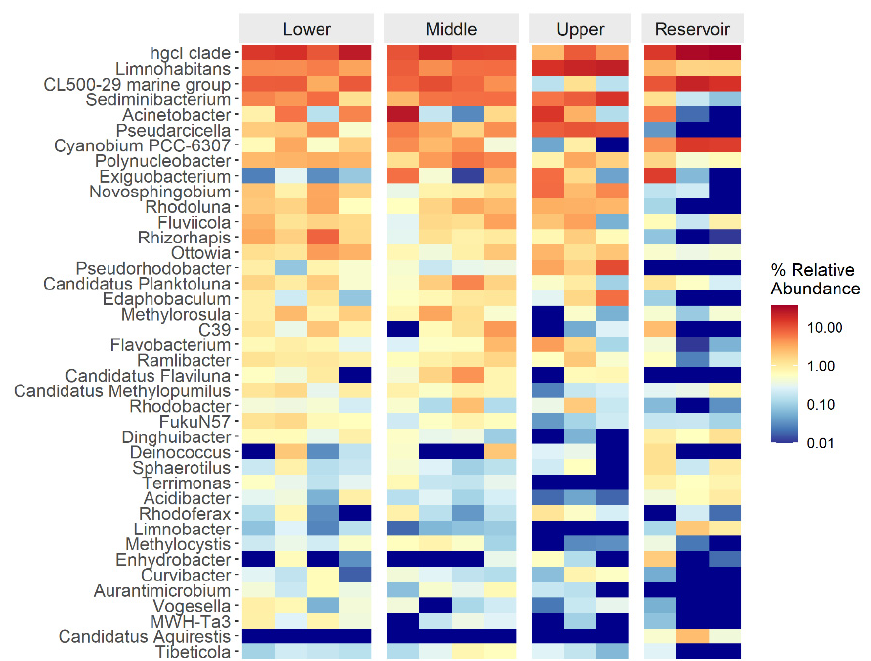
Figure 5. Top 40 taxa at genus level of the 14 water samples. The PCoA plot and PerMANOVA result (F = 3.27, p < 0.001) clearly show a separation between the reservoir and river samples on the first and second axis, which together accounted for 54.0% of the variation (Figure 6).